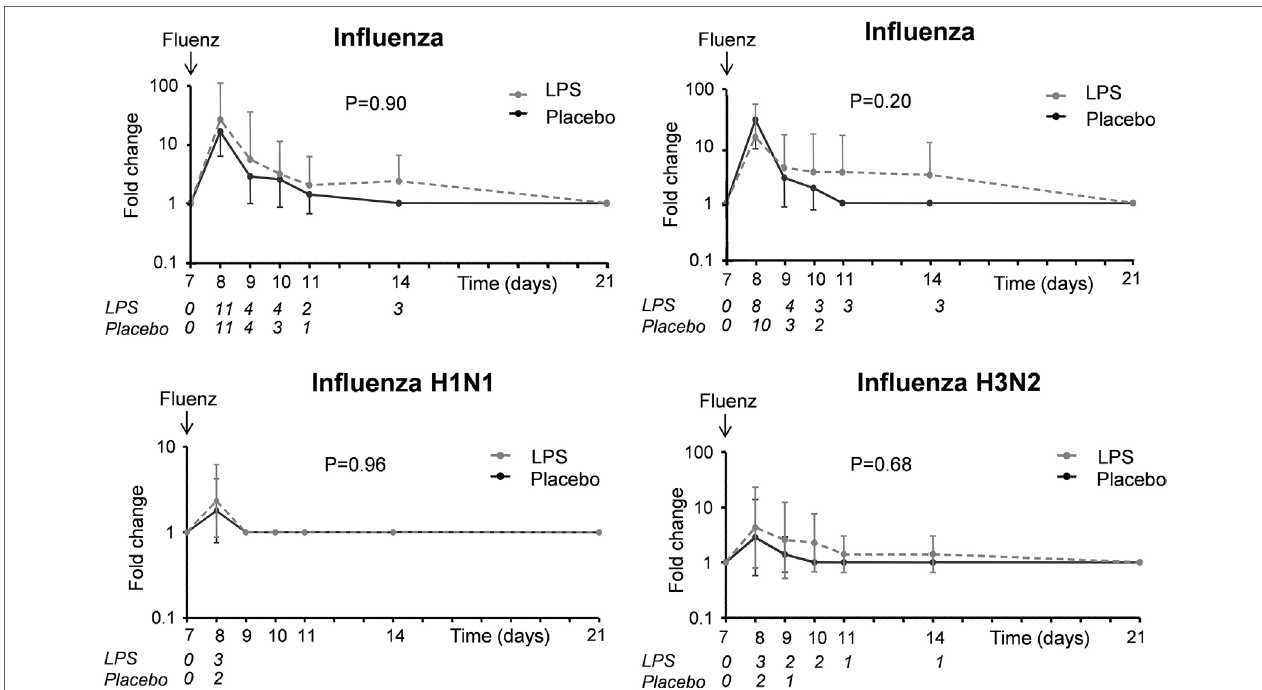
FigUre 8 | Viral load of the influenza A and B strains as well as the influenza A subtypes H1N1 and H3N2 in nasal wash of the 26 subjects who were challenged with lipopolysaccharide (LPS) ( n = 13) or placebo ( n = 13) on day 0 and displayed infectivity after inoculation with Fluenz on day 7. Data are presented as geometric means with 95% CI of fold changes in viral load compared with baseline, where viral load was undetectable ( C t > 40, so C t was set at 40). The italic numbers placed under the time points indicate how many subjects were PCR positive for the respective strain in each group.